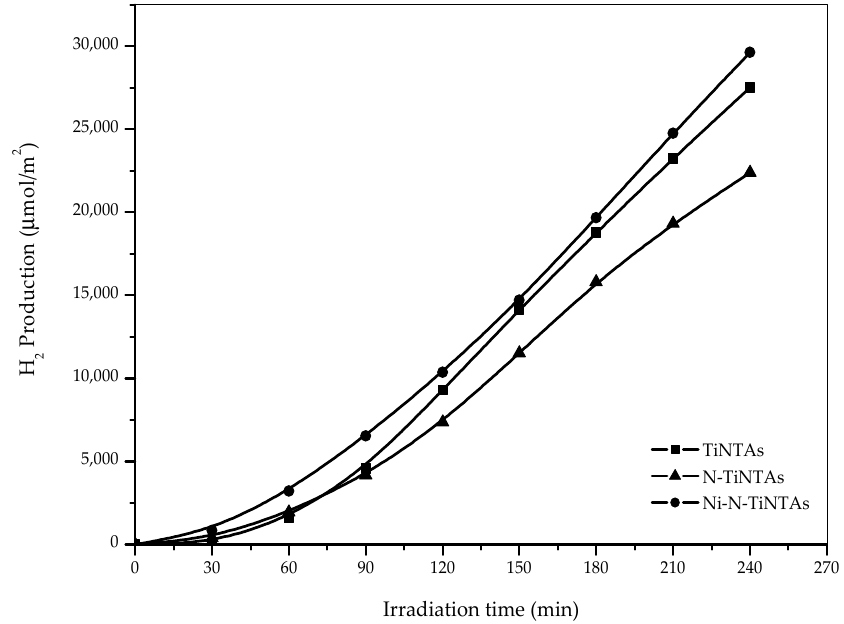
Figure 9. E ff ect of doped photocatalyst on the production of H 2 from glycerol–water mixture (10%v glycerol).